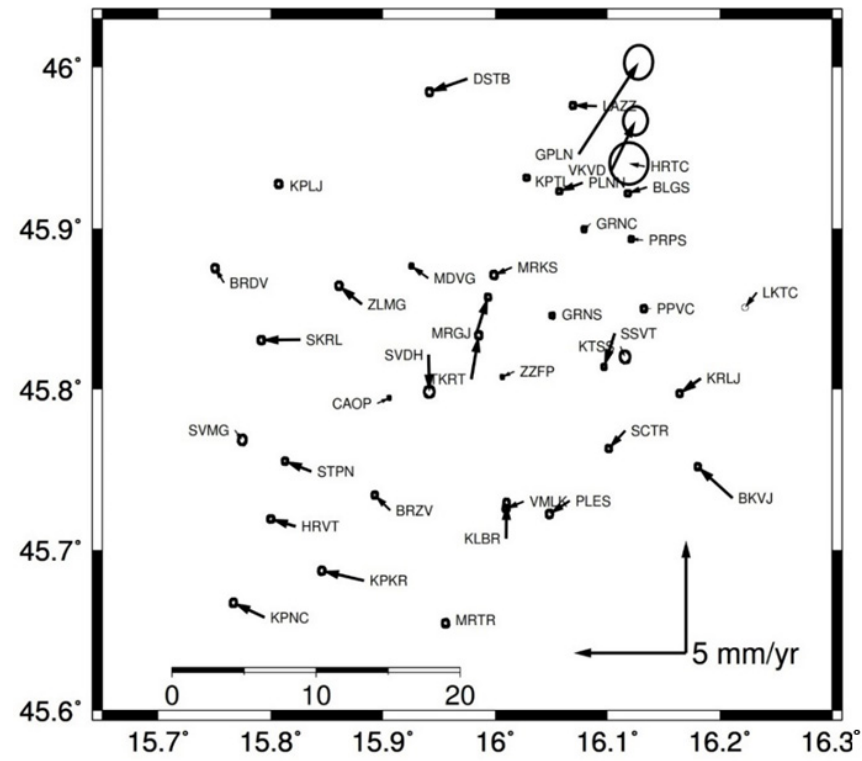
Figure 7. Cumulative geodetic velocity model on the geodynamic network points for the period 1997–2015. Formal errors scaled by 1.0, confidence interval 95%.